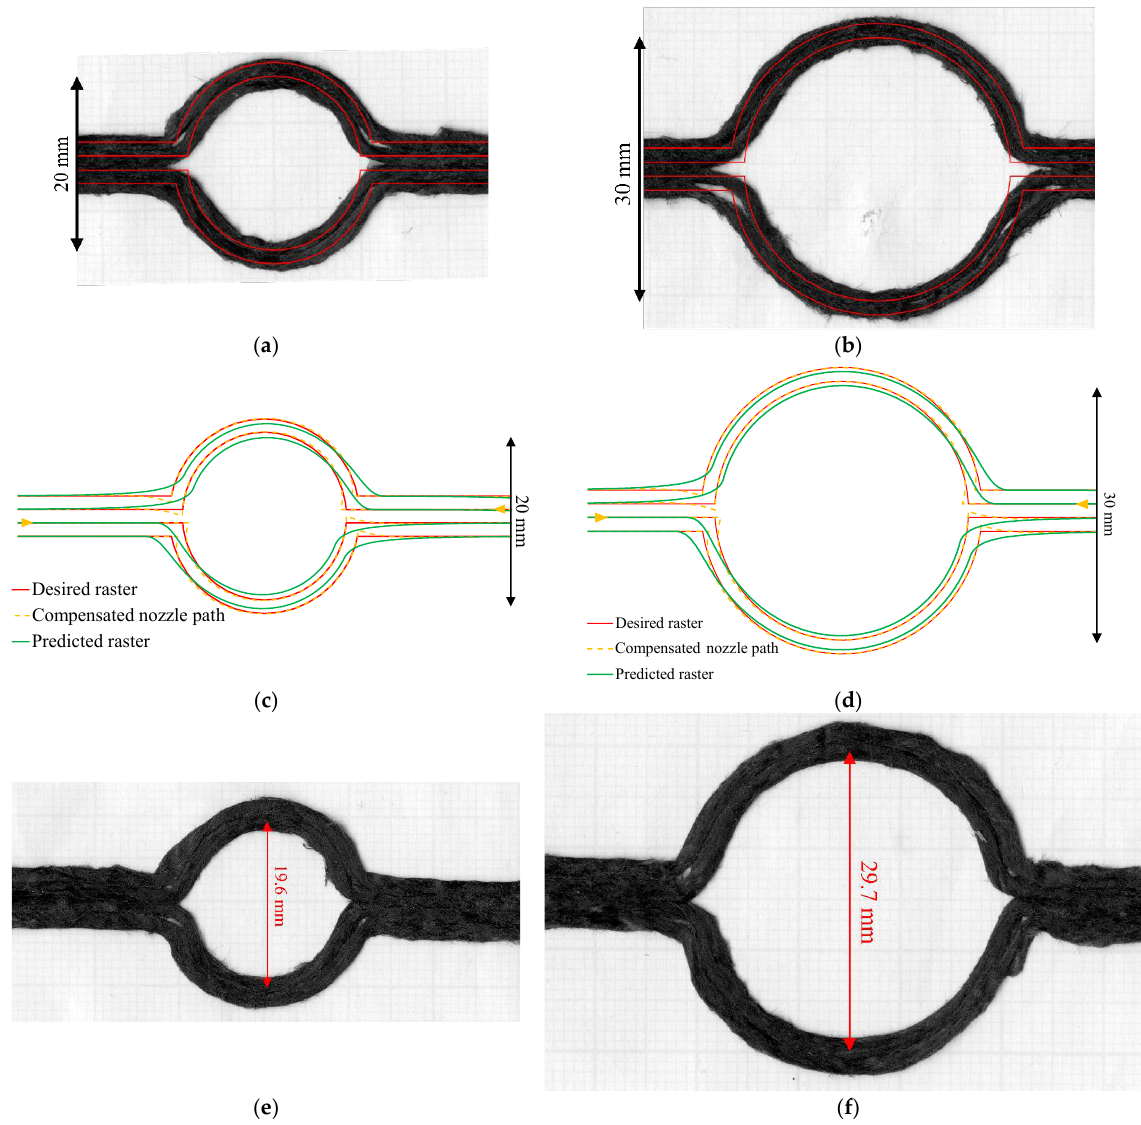
Figure 13. ( a , d ) Curvilinear printed parts of 20 and 30 mm diameter without path compensation; ( b ) and ( e ) the path compensation of a 20 and 30 mm diameter circle calculated with the PI controller (yellow dotted) showing the predicted printed path (green) and the desired raster (red); ( c ) and ( f ) curvilinear printed part of 20 mm and 30 mm diameter with the compensation. Using the proposed compensation algorithm, the new nozzle paths for D20 and D30 were generated, as seen in Figure 13b,e. Visually looking at the actual deposited raster in Figure 13c,f, the hole dimensions are almost the correct size, 19.6 and 29.7 mm, respectively, and the eye-shape effect at the corner is reduced. This is more accurate than the uncompensated parts in Figure 13a,d. At the transition, the top and bottom raster become closer to each other in the 20 mm diameter; this is slightly better in the larger diameter (30-mm diameter). This may be caused by the larger curvature size allowing more nozzle travelling time that may create a better bed adhesion. The filling of the second raster is slightly better than with no compensation. The second raster corner is almost fully filled by the overshooting of the second raster.